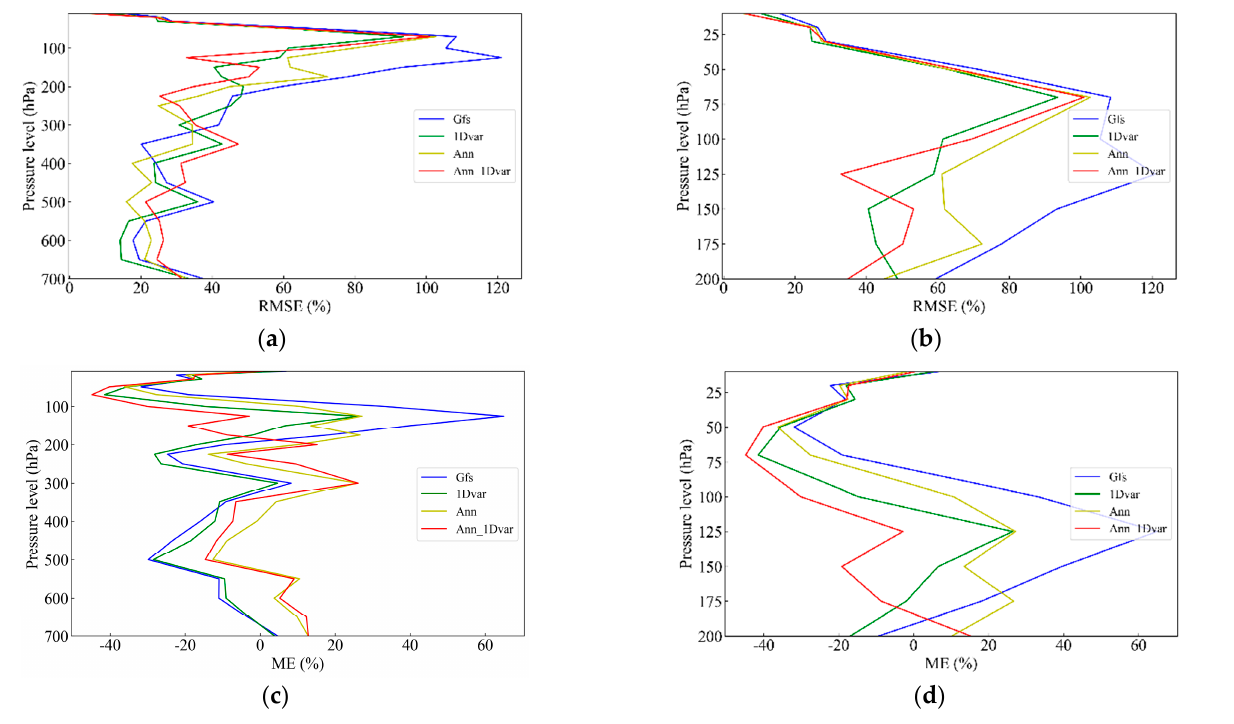
Figure 7. A comparison of the retrieval profile and initial profile, where the true value is taken from WOUDC ozone site data: ( a ) 1–700 hPa RMSEs (%) of two initial profiles and two retrieval profiles, ( b ) 1–200 hPa RMSE (%), ( c ) 1–700 hPa ME (%), ( d ) 1–200 hPa ME (%). The blue line, GFS, is the ozone profile of GFS forecast data, and the green line, 1Dvar, is the traditional 1D − VAR physical retrieval algorithm retrieval ozone profile result obtained with GFS data as the initial profile. The yellow line, Ann, is the profile obtained by the neural network model and the initial profile synthesized by GFS data, while the red line, Ann_1Dvar, is the retrieval result obtained by adding the neural network method to optimize the initial profile combined with the traditional 1D − VAR physical retrieval algorithm.